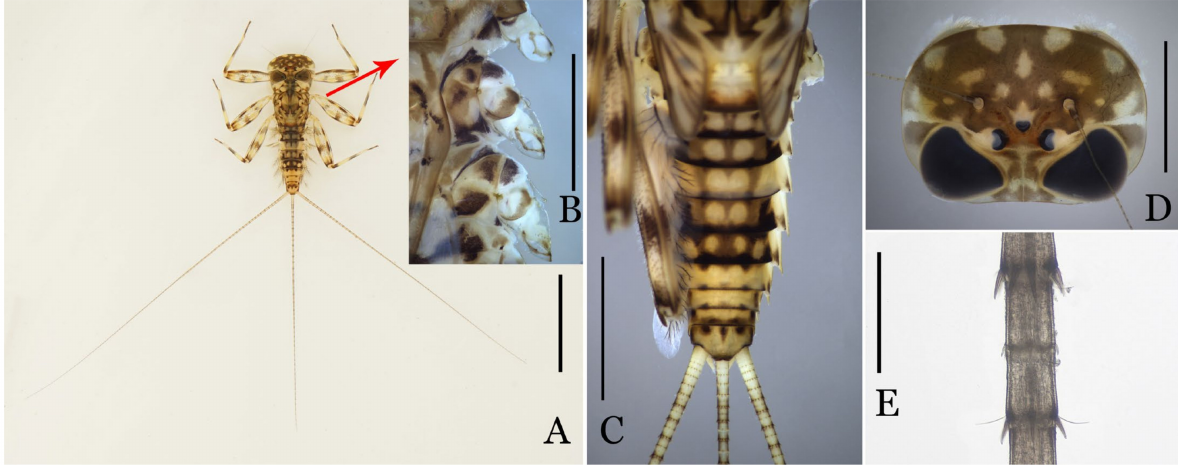
Figure 1. Nymph of Maculogenia ngi (digital photos): ( A ) Nymphal habitus and supracoxal sclerites; ( B ) supracoxal spurs; ( C ) abdominal terga head capsule and pronotum; ( D ) head capsule; ( E ) caudal filaments (near base). Scale bars: ( A ) = 4.0 mm; ( B ) = 1.0 mm; ( C ) = 2.0 mm; ( D ) = 1.0 mm; ( E ) = 0.3